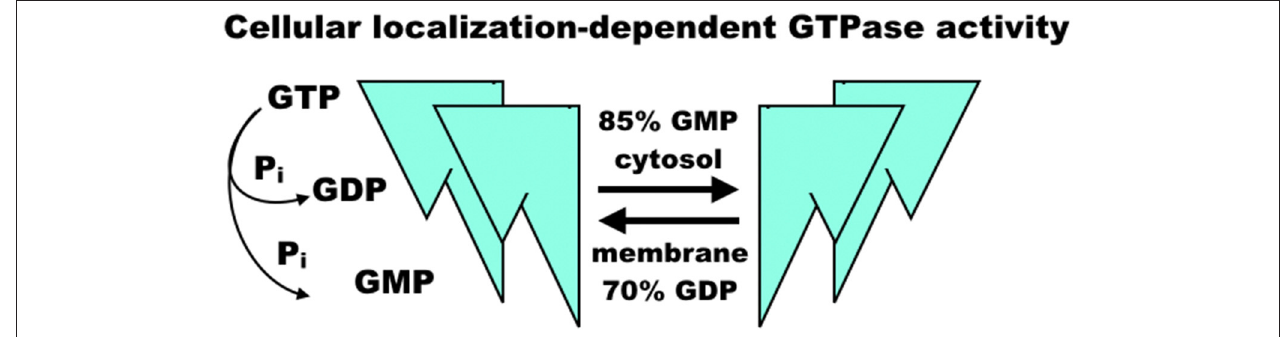
FIGURE 3 | Model of GBP1 GTPase activity. GBP1 binding of GTP appears to trigger homodimerization and further self-assembly into homotetramers, fibrils, or larger molecular complexes with diverse binding partners regulating proliferation and inflammation. When membrane-bound, GBP1 primarily produces GDP, releasing a single phosphate, whereas cytosolic GBP1 preferentially produces GMP and a diphosphate group. The sequence of self-assembly states, functional relationship to diverse binding partners, and precise regulation of GTPase activity in each is, as yet, un-characterized.